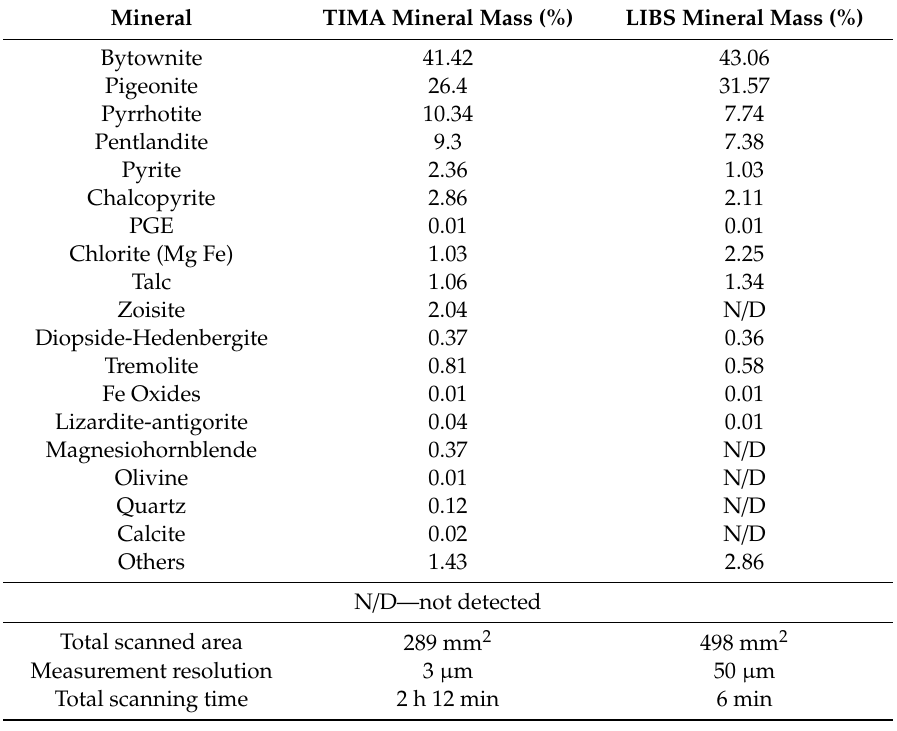
Table 5. The mineral mass distribution obtained by TIMA and LIBS CORIOSITY on PGE1a. Mineral